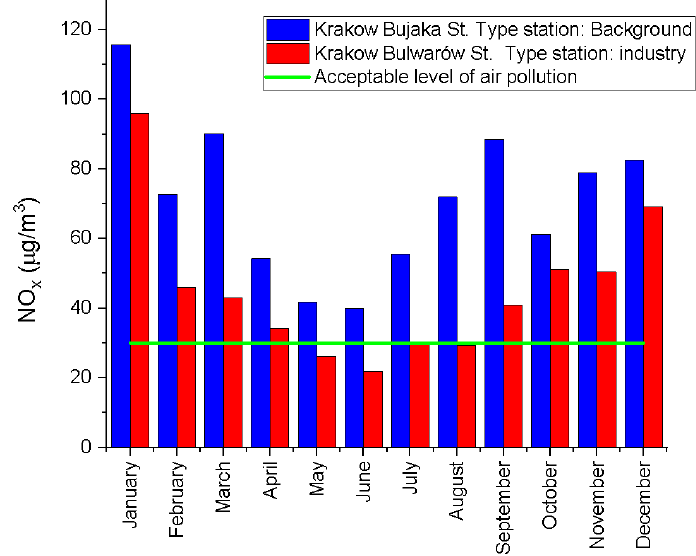
Figure 13. Average NOX concentration in individual months of 2020.